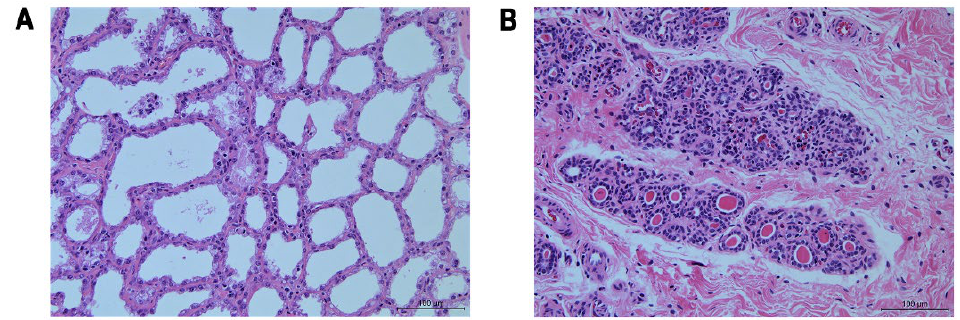
Figure 1. Morphological characteristics of the mammary gland in jennies observed after H & E staining (40 × ). ( A ) Paraffin section of jenny mammary gland during lactation. ( B ) Paraffin section of jenny mammary gland during the nonlactating period. Nuclei are dyed blue by hematoxylin, and the cytoplasm is stained pink by